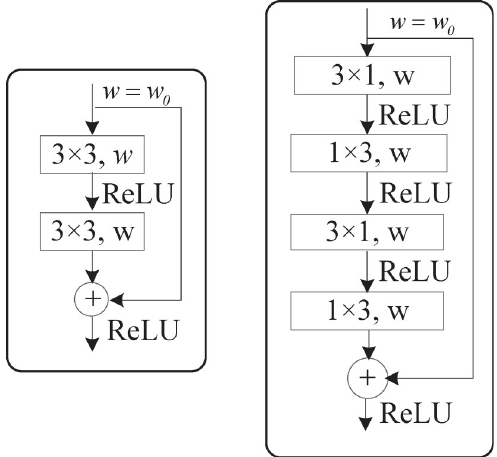
Fig 1. Diagram of the bottleneck residual block and Non-bt-1D module, where w 0 denotes the number of channels in the upper layer output and w denotes the number of channels in the input.